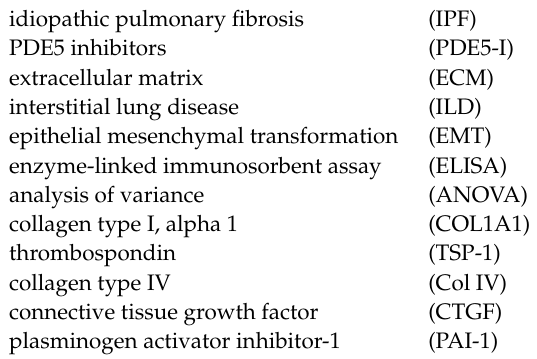
mice. Figure S6: Sildenafil does not significantly inhibit TGF-b1-mediated, matrix-associated mRNA levels in lung